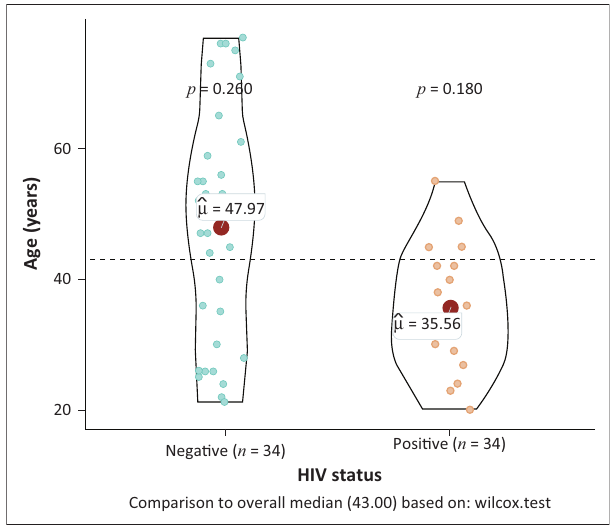
FIGURE 1: Comparative age in human immunodeficiency virus-negative individuals undergoing cholecystectomy compared to women living with human immunodeficiency virus.